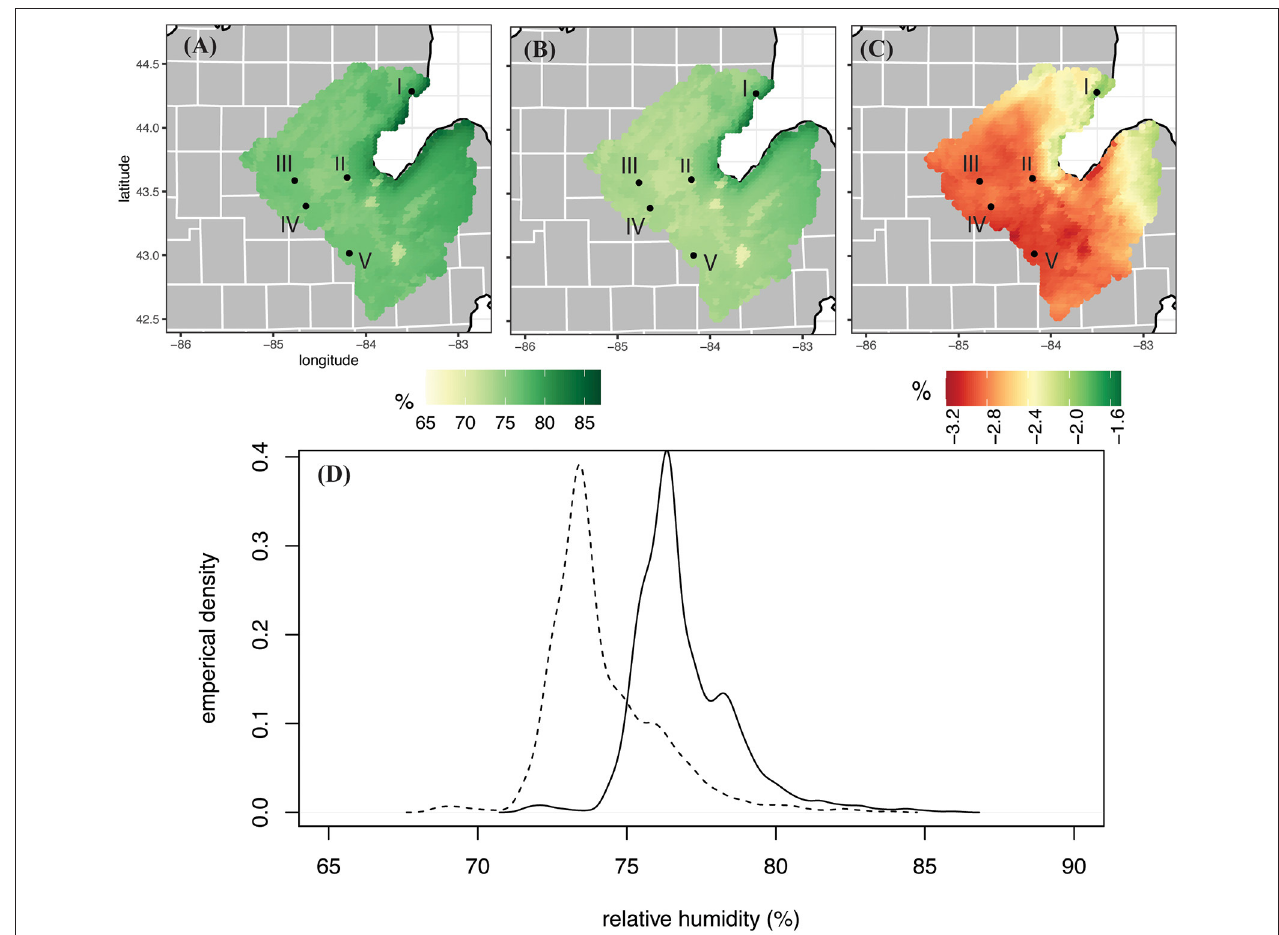
FIGURE 4 | Same as Figure 2 , but for mean daily relative